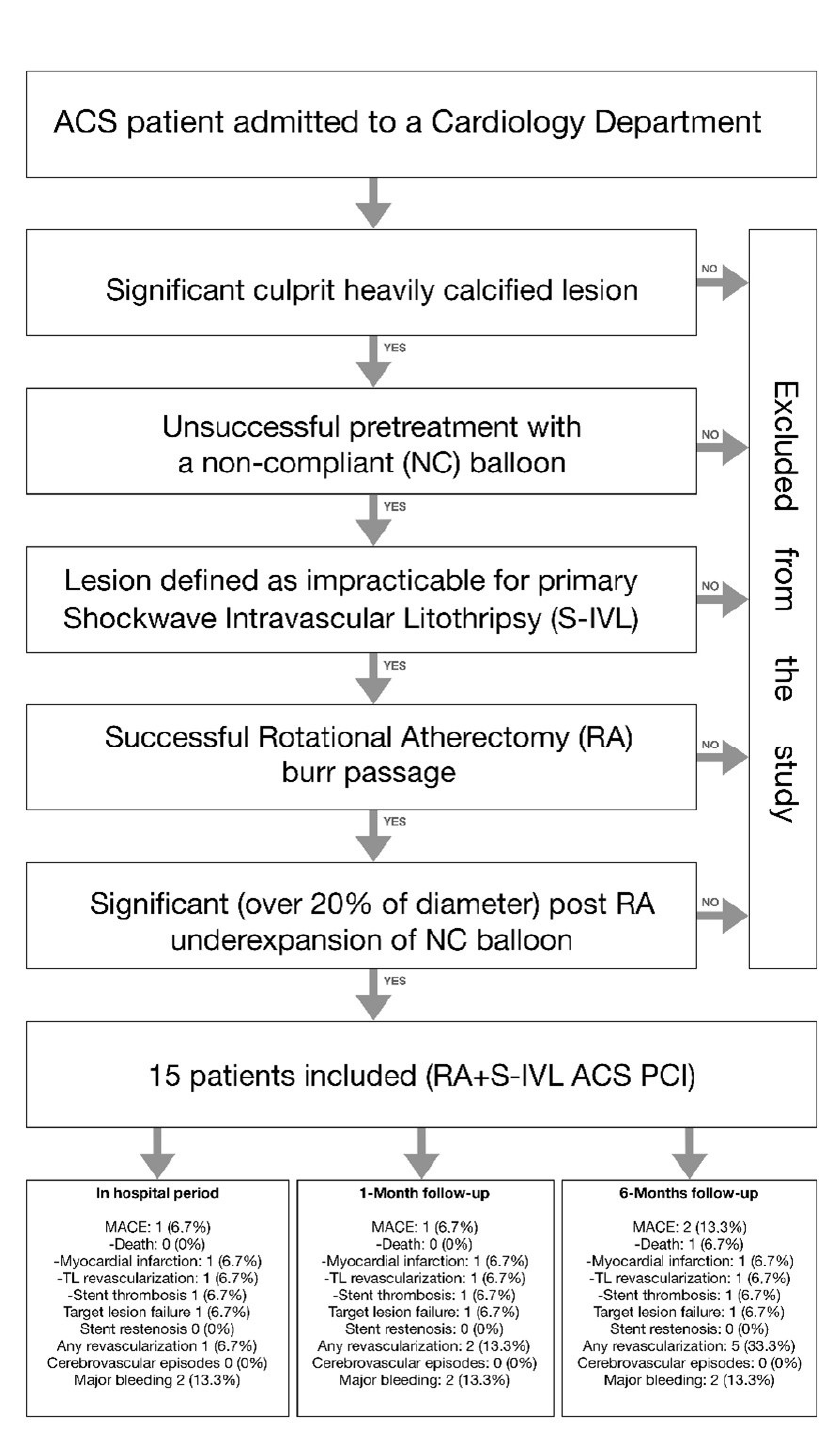
Figure 1. Study inclusion and exclusion